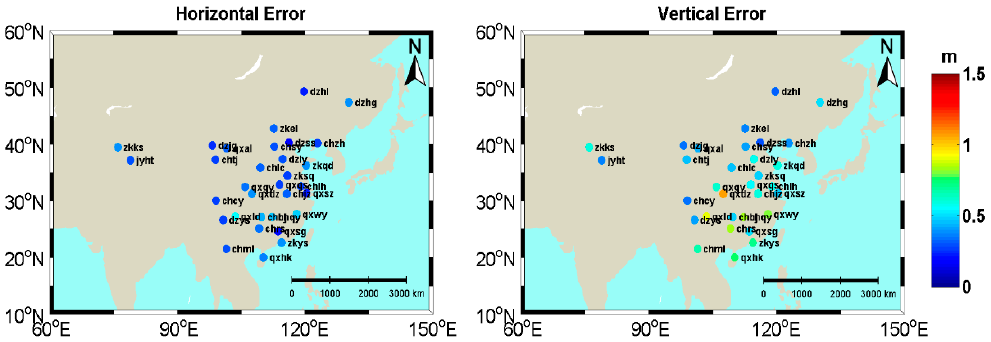
Figure 13. GPS real-time single-frequency PPP positioning accuracy at the 95% confidence level.